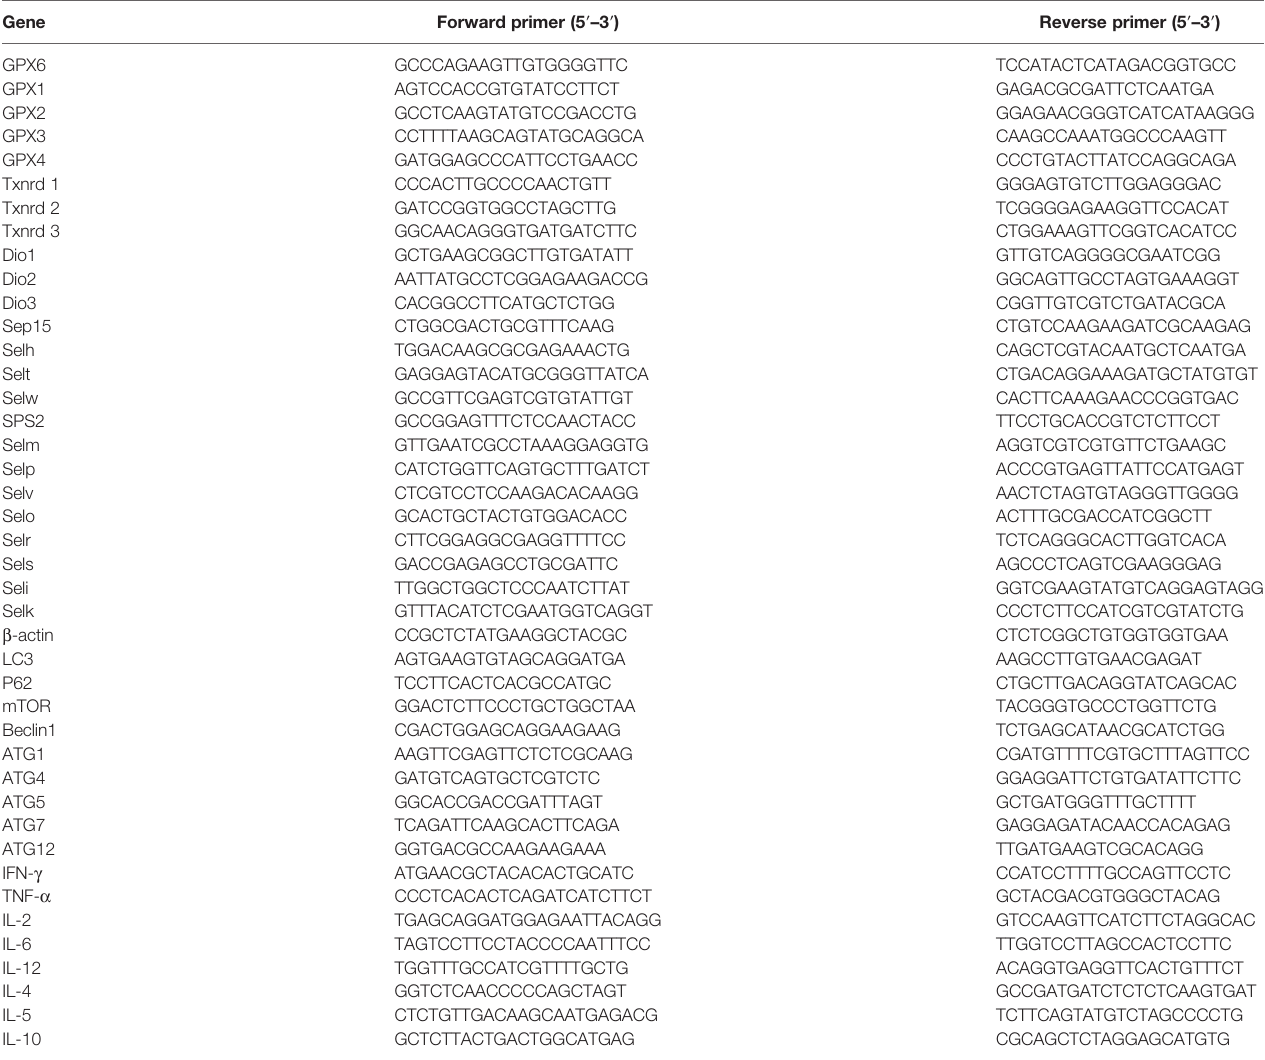
TABLE 1 | The primers used in the present